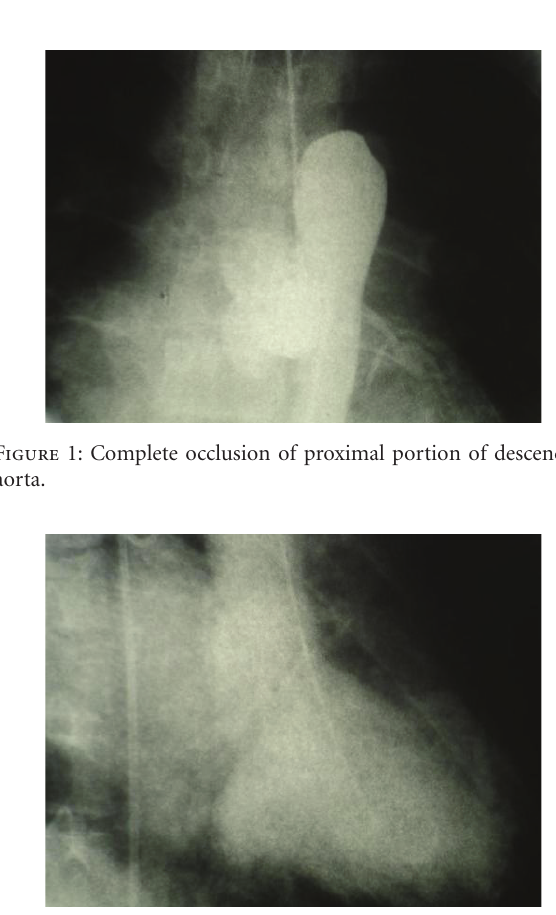
Figure 4: Complete interruption of